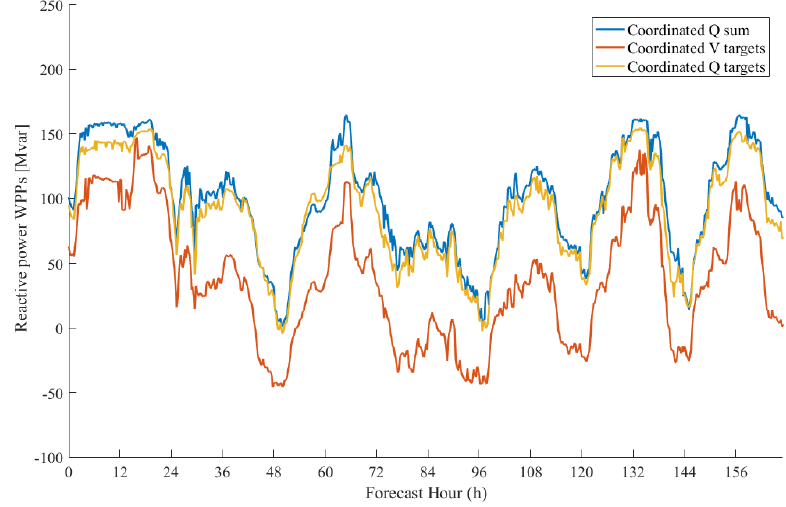
Figure 14. Reactive power exchange between transmission and distribution grid (first day).